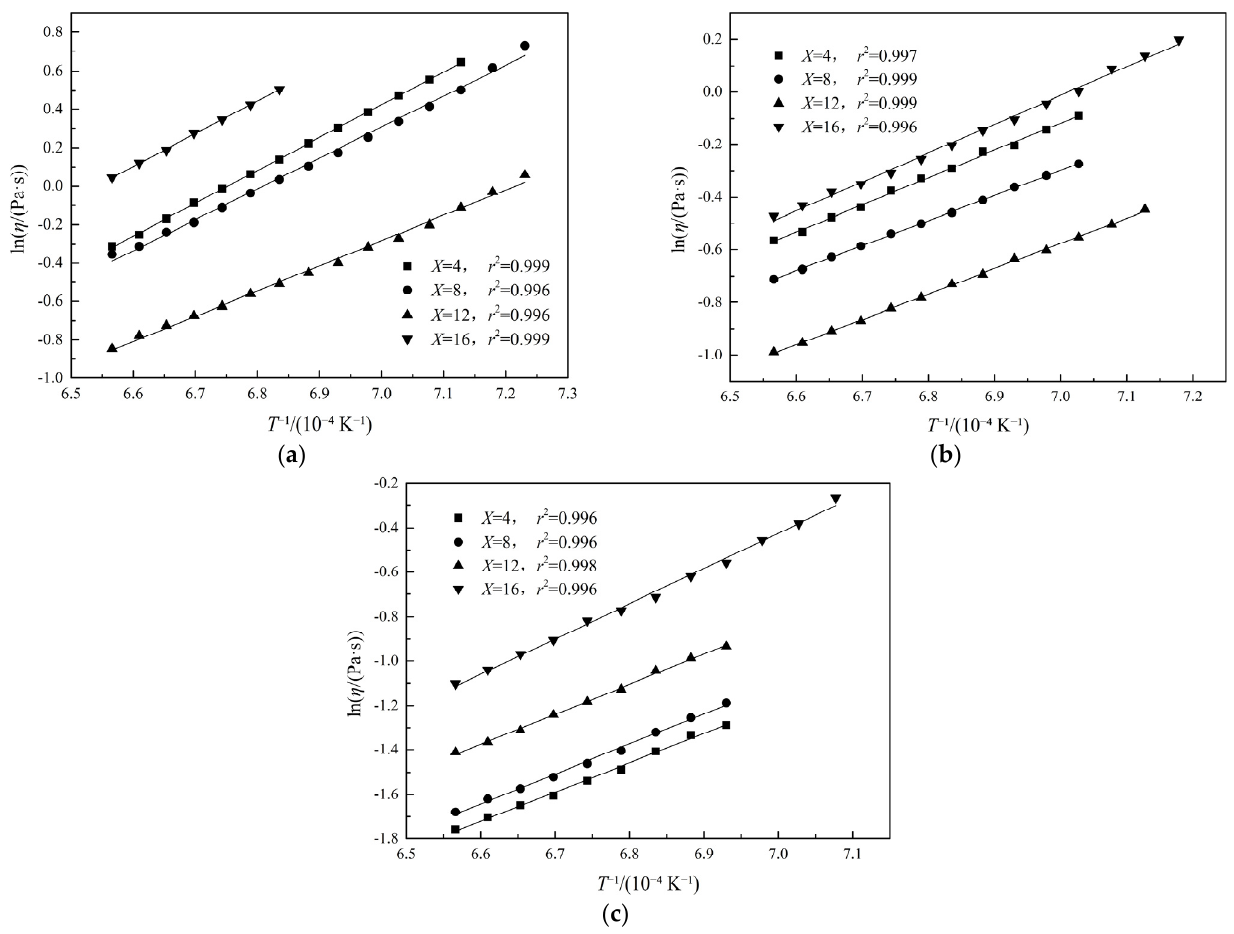
Figure 14. The ln η and 1/ T fi tt ing results of the FeO − X wt%Fe 2 O 3 − SiO 2 − 8 wt%CaO − 3 wt%MgO − 3 wt%Al 2 O 3 slag systems at various Fe 2 O 3 contents and at a fixed Fe/SiO 2 ratio of ( a ) 0.8; ( b ) 1.0 and ( c ) 1.2 .